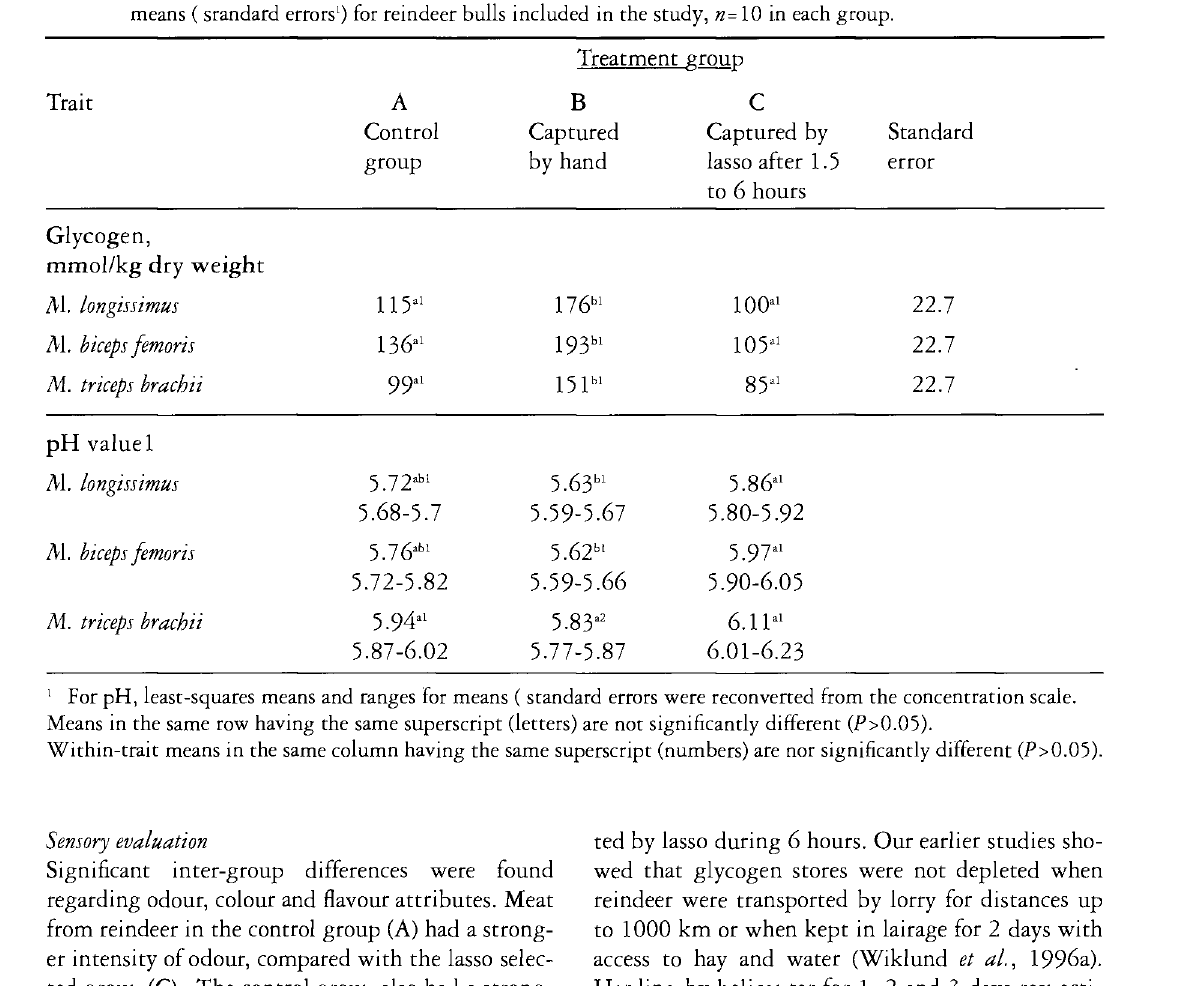
Table 3. Glycogen content and ultimate pH value in M. longissimus, M. biceps femoris and M. triceps brachii (least-squares means ( srandard errors 1 ) for reindeer bulls included in the study, n= 10 in each